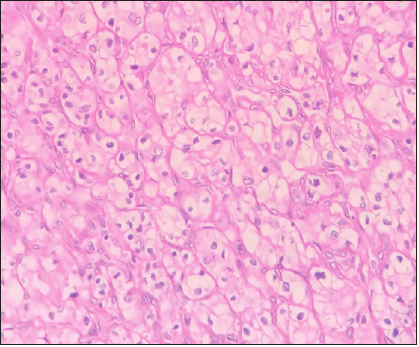
Figure 3. Detailed view of the tumor in the kidney. The tumor consisted of pleomorphic cells with irregular nuclei and large pale cytoplasm with indistinct cell borders organized in a nested growth pattern (Magnification x40).